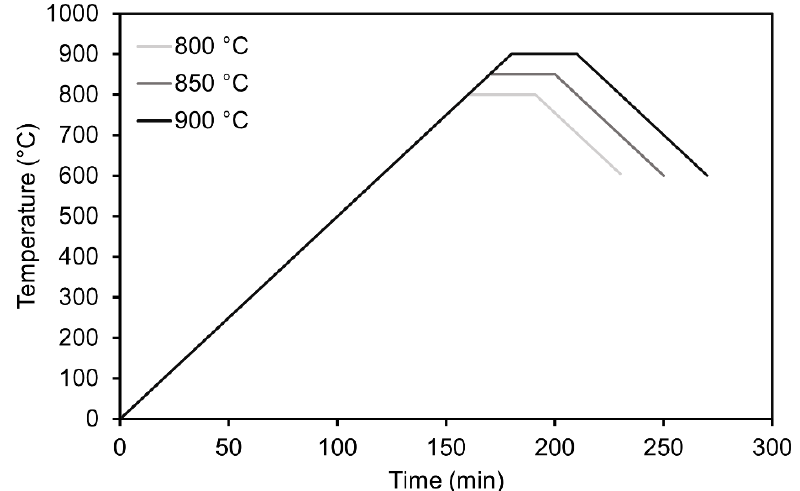
Figure 1. Firing curves used for samples foamed at 800, 850 and 900 °C.